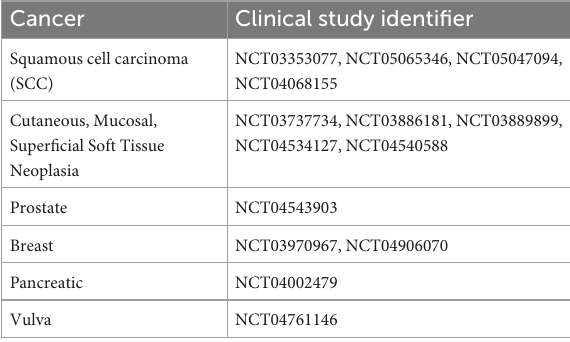
TABLE 1 List of ongoing clinical trials with diffusing alpha-emitters radiation therapy